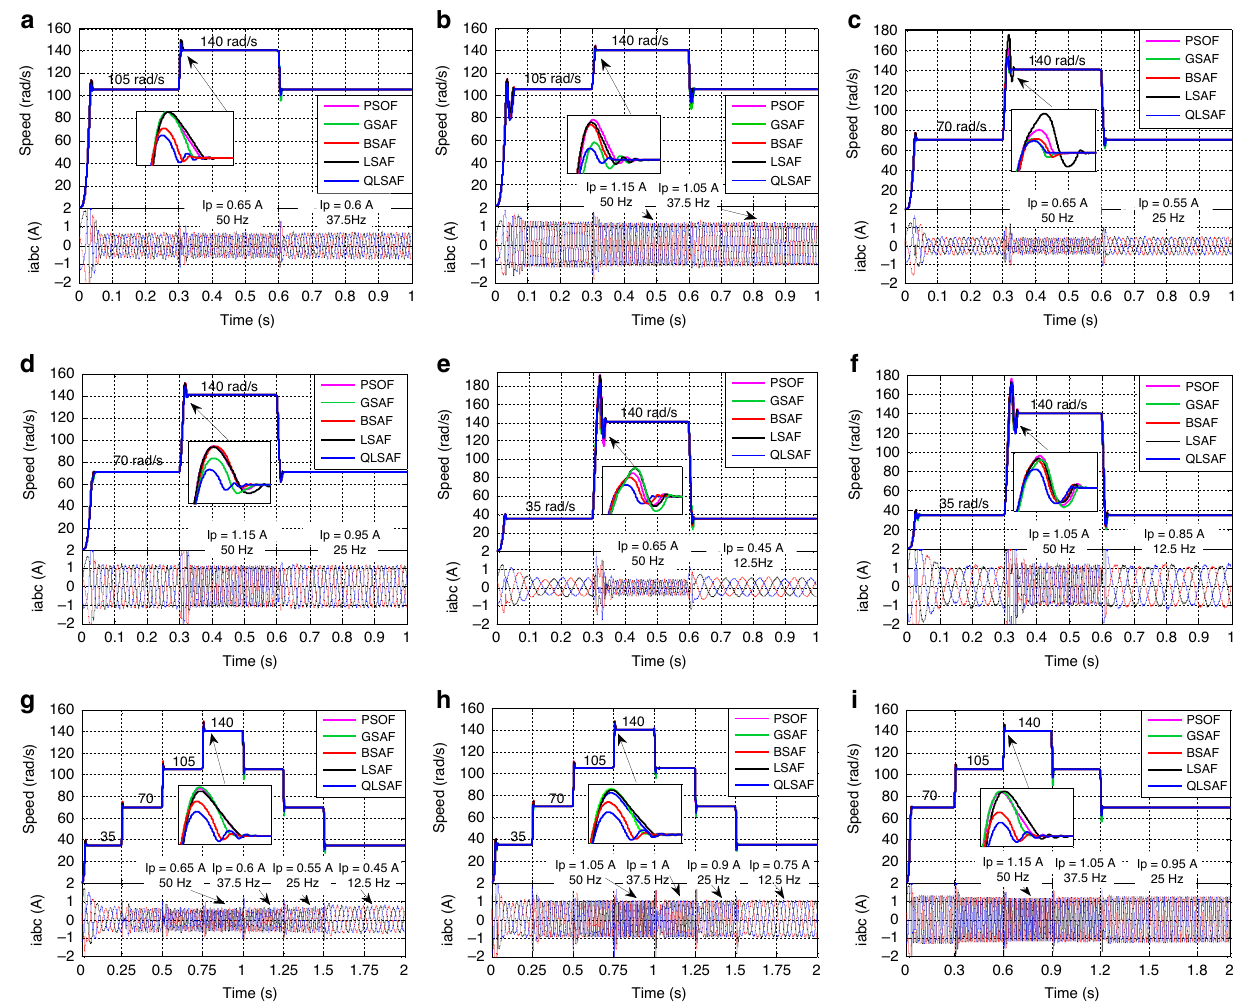
Fig. 4 Simulation results under step response test and down-to-up-to-down test. a QLSA performance in step response test under the speed varying from 105 rad/s to 140 rad/s with no-load. b QLSA performance in step response test under the speed varying from 105 rad/s to 140 rad/s with 2 Nm load. c QLSA performance in step response test under the speed varying from 70 rad/s to 140 rad/s with no-load. d QLSA performance in step response test under the speed varying from 70 rad/s to 140 rad/s with 2 Nm load. e . QLSA performance in step response test under the speed varying from 35 rad/s to 140 rad/s with no-load and, f . QLSA performance in step response test under the speed varying from 35 rad/s to 140 rad/s with 1 Nm load. g QLSA performance in down-to-up-to-down test under the speed varying from 35 rad/s to 70 rad/s, from 70 rad/s to 105 rad/s and from 105 rad/s to 140 rad/s at no-load. h QLSA performance in down-to-up-to-down test under the speed varying from 35 rad/s to 70 rad/s, from 70 rad/s to 105 rad/s, from 105 rad/ s to 140 rad/s at 1 Nm load. i QLSA performance in down-to-up-to-down test under the speed varying from 70 rad/s to 105 rad/s, from 105 rad/s to 140 rad/s at 2 Nm